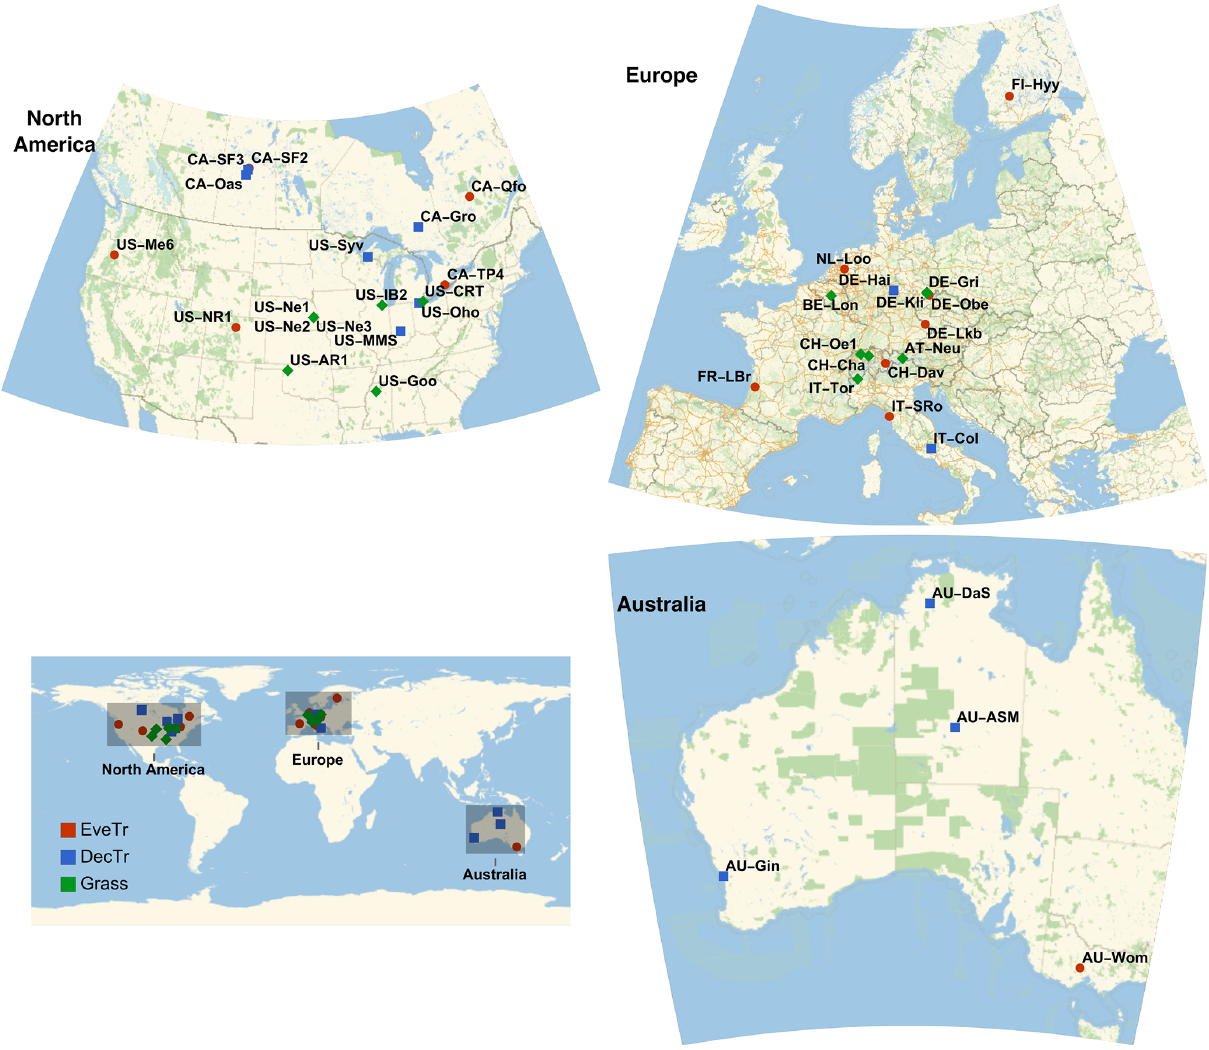
Figure 2. Location of FLUXNET sites (Table 3) coded by into three land cover types: deciduous trees (DecTr), evergreen trees (EveTr) and grass (Grass). Source of base map: © OpenStreetMap contributors, 2021. Distributed under the Open Data Commons Open Database License (ODbL)